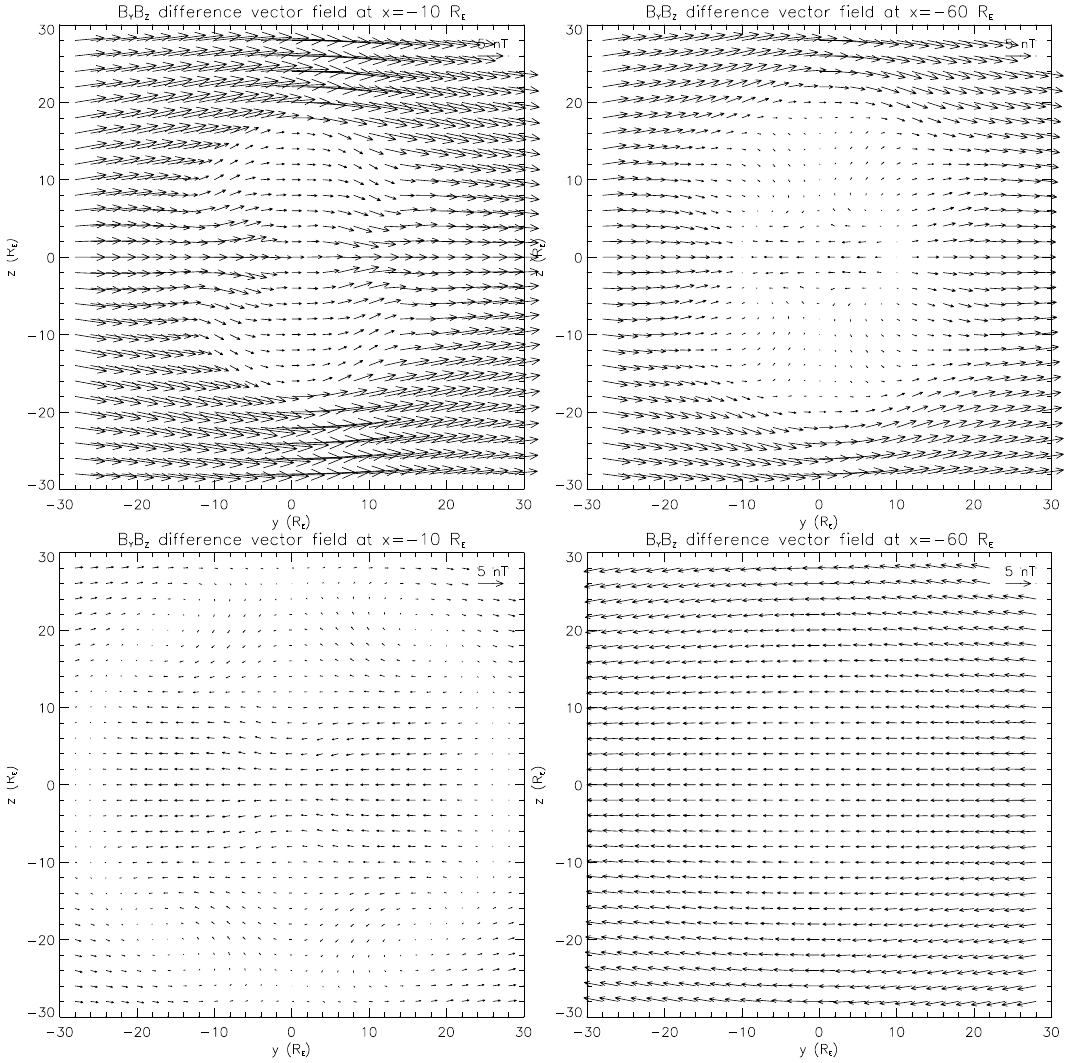
Fig. 9. The additional magnetic field shown at different tail cross sections during the fast IMF B y sign-change case (run 2a). The plots are produced in the same way as Fig. 3 and show the additional magnetic field 22min after the center of the sign-change region has passed the dayside